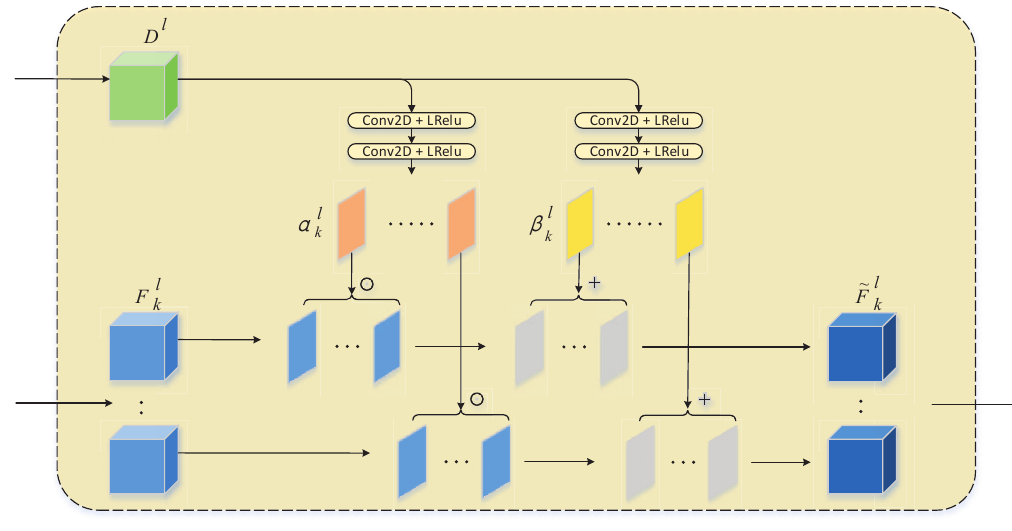
Figure 2. Spatial feature transforms (SFT) used in